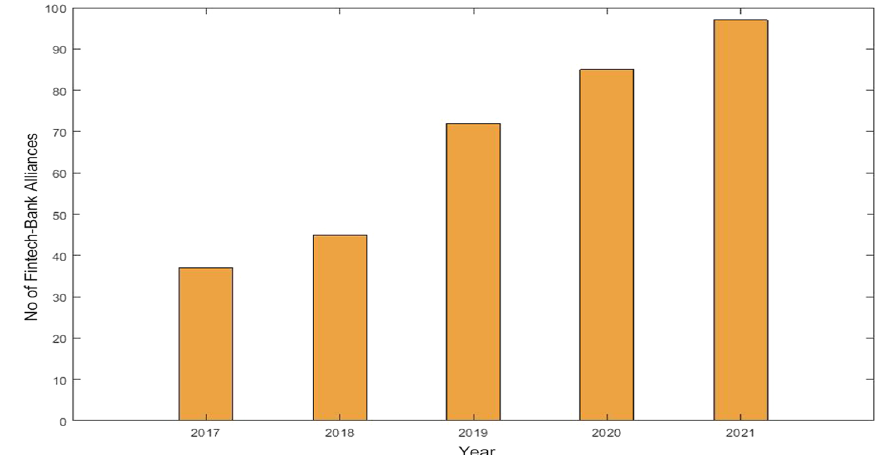
Fig. 3 Growth of FinTech in